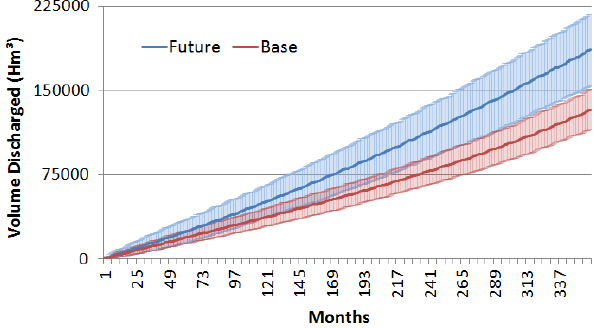
Figure 6. Mean and 90% confidence interval for the mean monthly flows based on the stochastic series generated, during the base (1961–1990) and future periods (2011–2040), at Santo Ângelo gauge